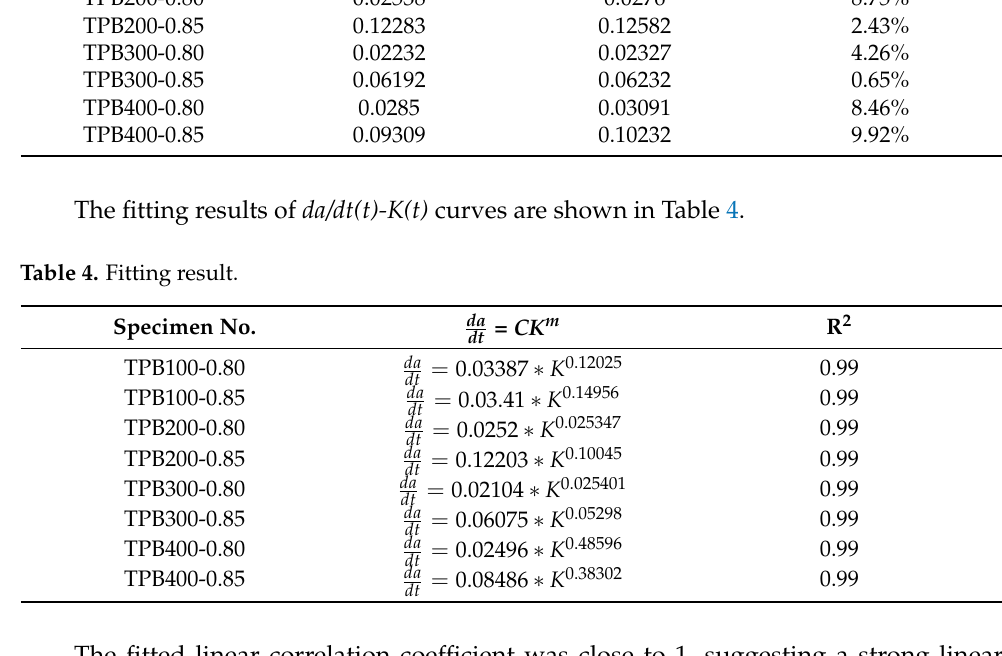
Figure 3. Time-dependent fracture curves da/dt (t)-K(t) . Figure 3. Time ‐ dependent fracture curves da/dt (t) ‐ K( t ). Table 3. Phase 2 rate information. According to Equations (5) and (6), the crack propagation rate da/dt I–II at the boundary between the first and second stages and the crack propagation rate da/dt II–III at the bound ‐ ary between the second and third stages increased with the rising load level. Such findings Specimen No. are consistent with the data in Table 3. Table 3. Phase 2 rate information.